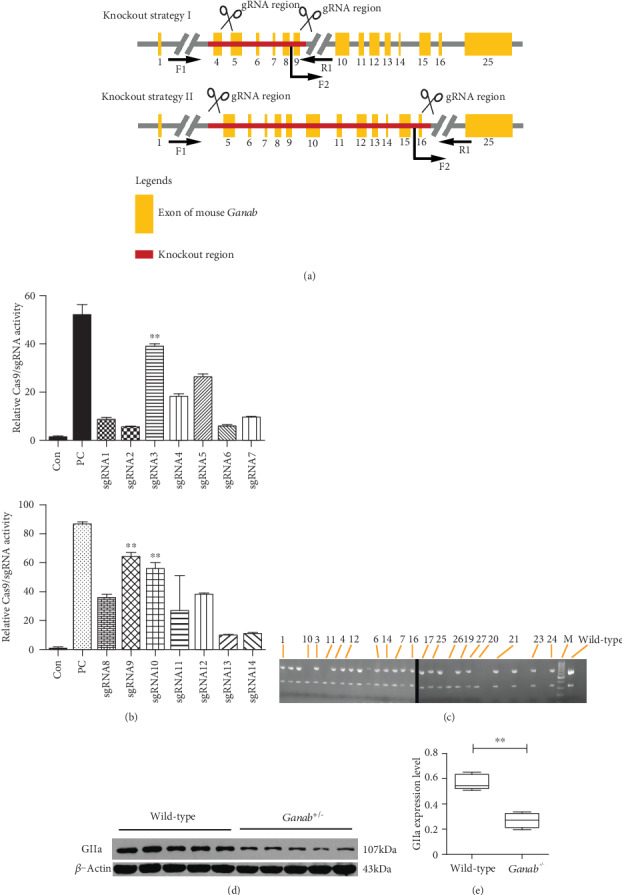

Ganab-haploinsufficient mice were constructed via two strategies. (a) Ganab+/-mouse construction strategies. Strategy I, the designed sgRNA was located in the nonconserved region between intron 4 and intron 10. Strategy II, the designed sgRNA was located in the nonconserved region between intron 5 and intron 17. (b) Screening of sgRNA in targeting vectors, and sgRNA3 and sgRNA9 with higher viability were selected for efficient Ganab gene knockout. (c) Genotyping was performed on randomly selected mice (wild-type and mutant mice) to confirm the absence of the Ganab gene in the mutant mice. Four homozygotes were found in 3.5-day mouse embryos constructed by strategy II. PCR product size for homozygotes: 622 bp/335 bp; heterozygotes: 622 bp/658 bp/335 bp; wild-type allele: 658 bp/335 bp. (d, e) Compared with that in the wild-type group, the GIIa protein expression in the Ganab+/- group (strategy I) was significantly reduced, and the difference was statistically significant (n = 5). Data are presented as the mean ± SEM. ∗∗P < 0.001 by 2-tailed t test.